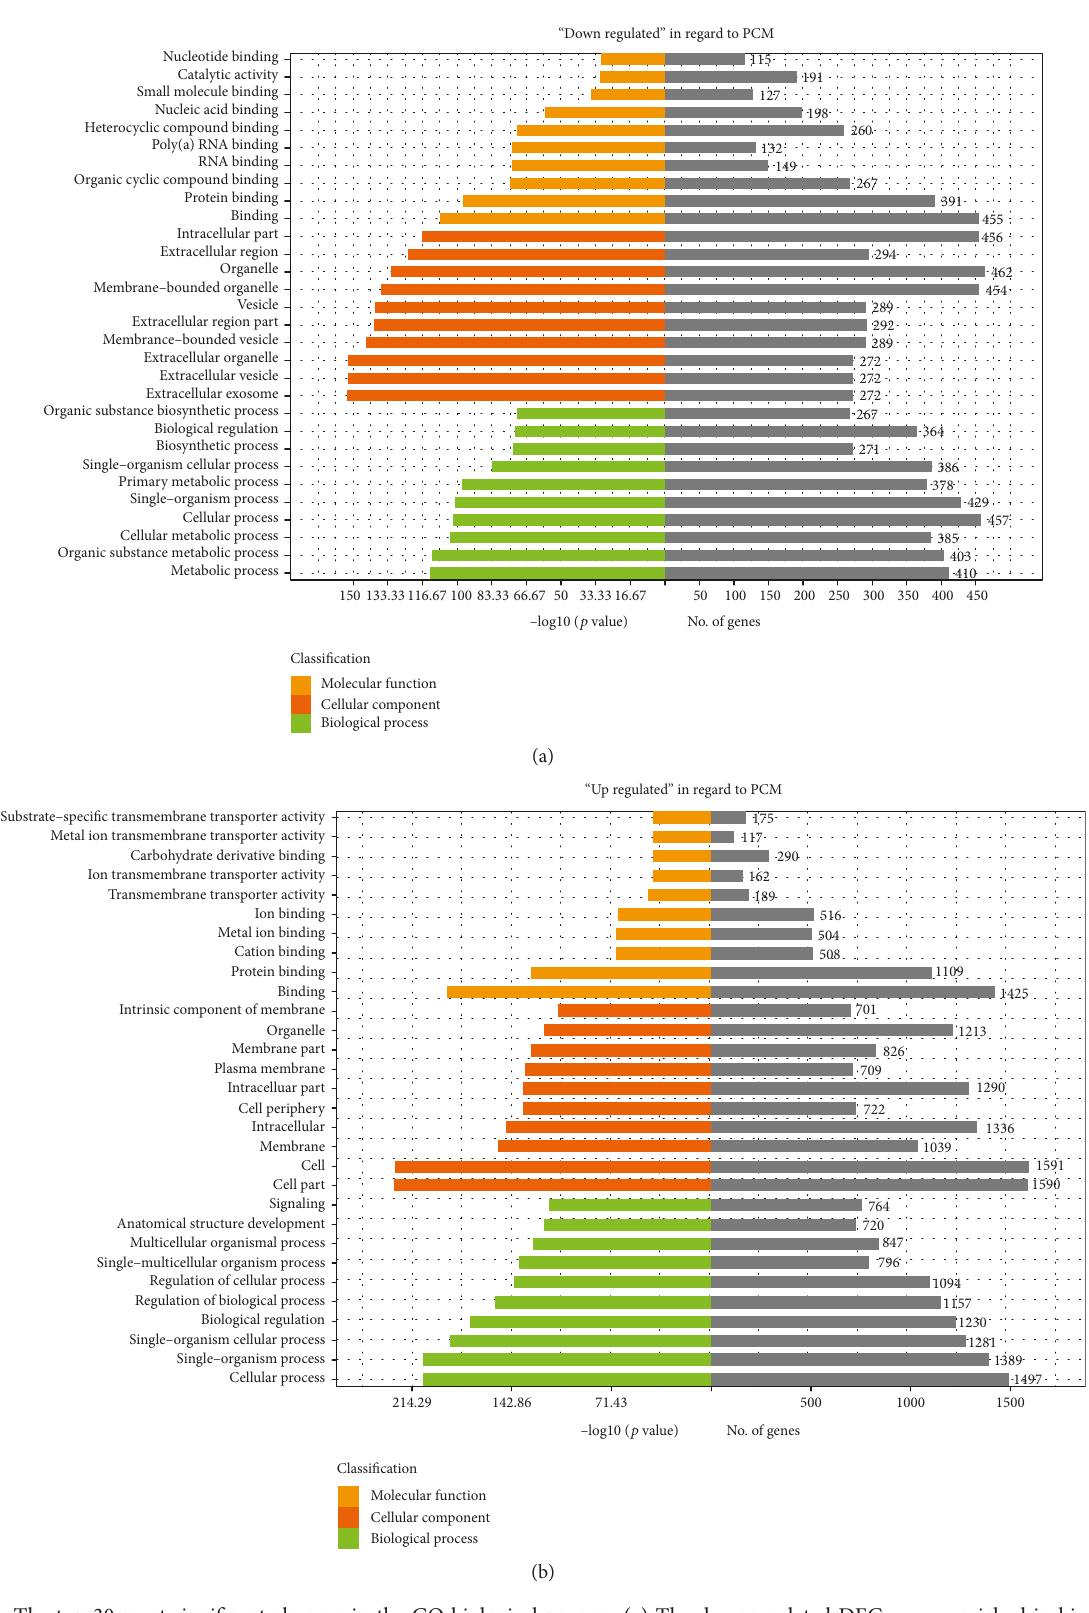
Figure 2: The top 30 most signi fi cant changes in the GO biological process. (a) The downregulated DEGs were enriched in binding, the metabolic process, and the biosynthetic process. (b) The upregulated DEGs were enriched in the biological process as a cellular process, regulation of biological process, and regulation of cellular